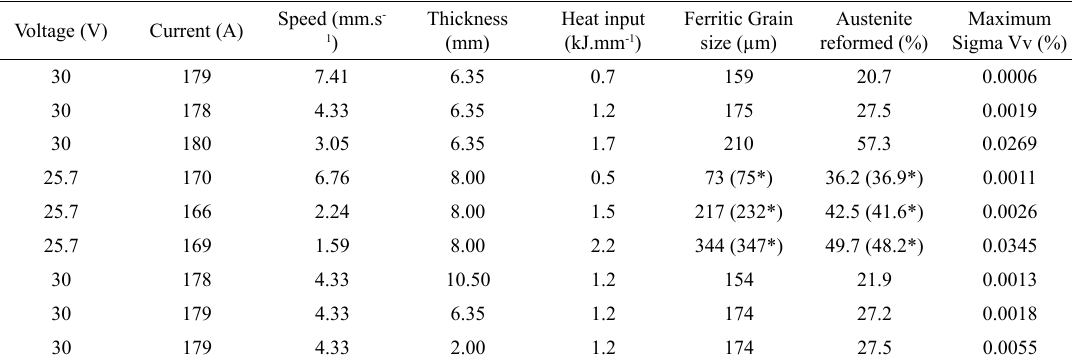
Table 4. Maximum sigma and reformed austenite phases volumes fractions and grain size predicted for the welding conditions